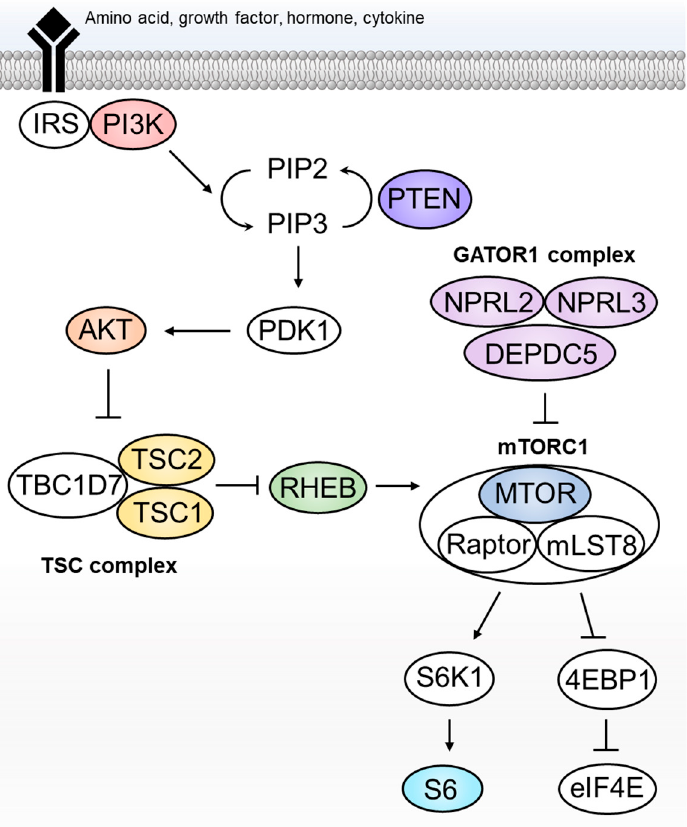
Figure 1. The mechanistic target of rapamycin (mTOR) signalling pathway. Pathogenic germline or somatic variants are identified in the coloured components. Specifically, PTEN and S6 are associated with hemimegalencephaly (HME) only, while the rest are associated with both focal cortical dysplasia (FCD) and HME.